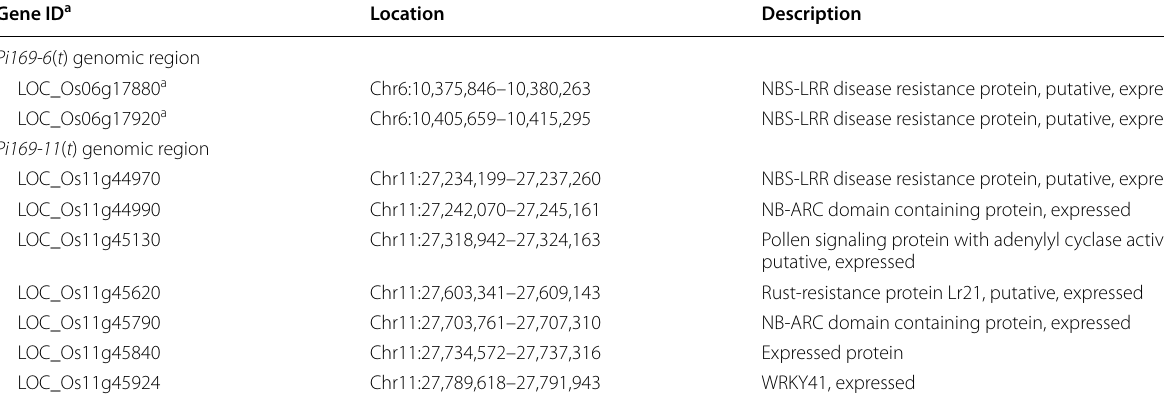
Table 1 Candidate R genes identified in Pi169-6 ( t ) and Pi169-11 ( t ) of